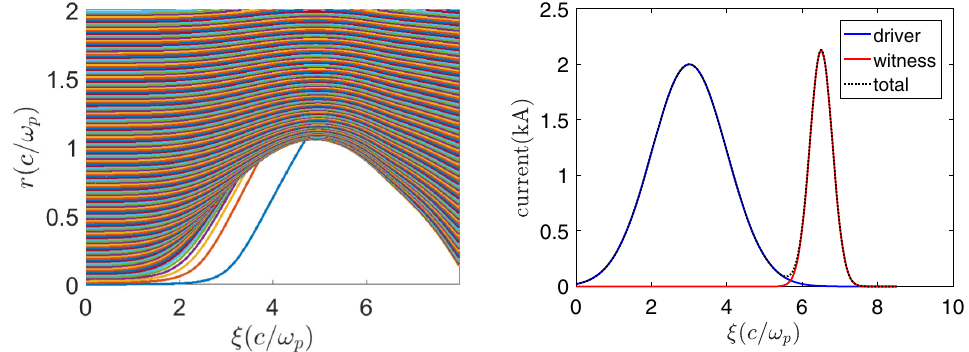
FIG. 1. Right figure: Current profiles of the Gaussian drive and witness beams. Left figure: Electron trajectories in the r − ξ plane. The formation of a plasma cavity (or bubble) is evident.